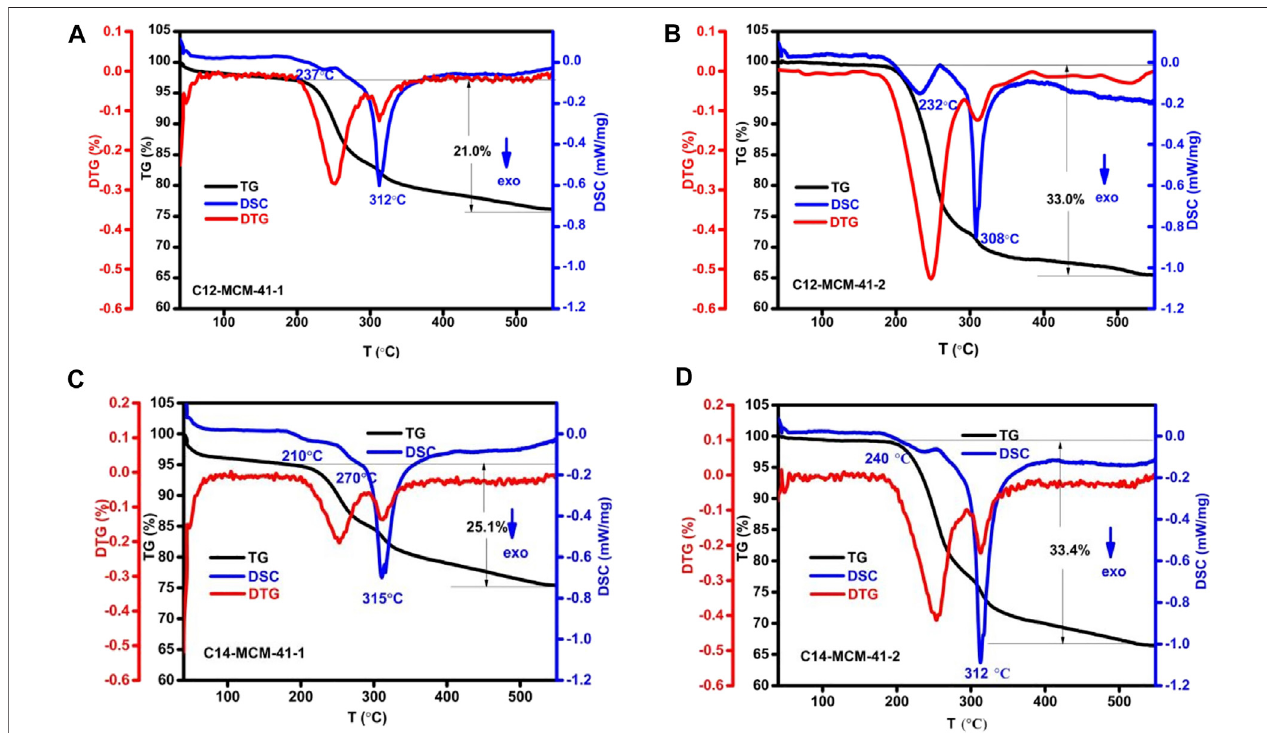
FIGURE 3 | Thermal analysis curves of (A) C12-MCM-41-1, (B) C12-MCM-41-2, (C) C14-MCM-41-1, (D)